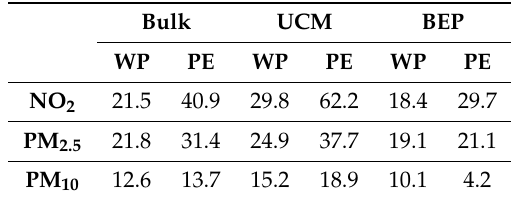
Table 2. Statistics of surface pollutants: mean bias between the simulations and observations of NO 2 , PM 2.5 , and PM 10 during Whole Period (WP) and Pollution Episode (PE).